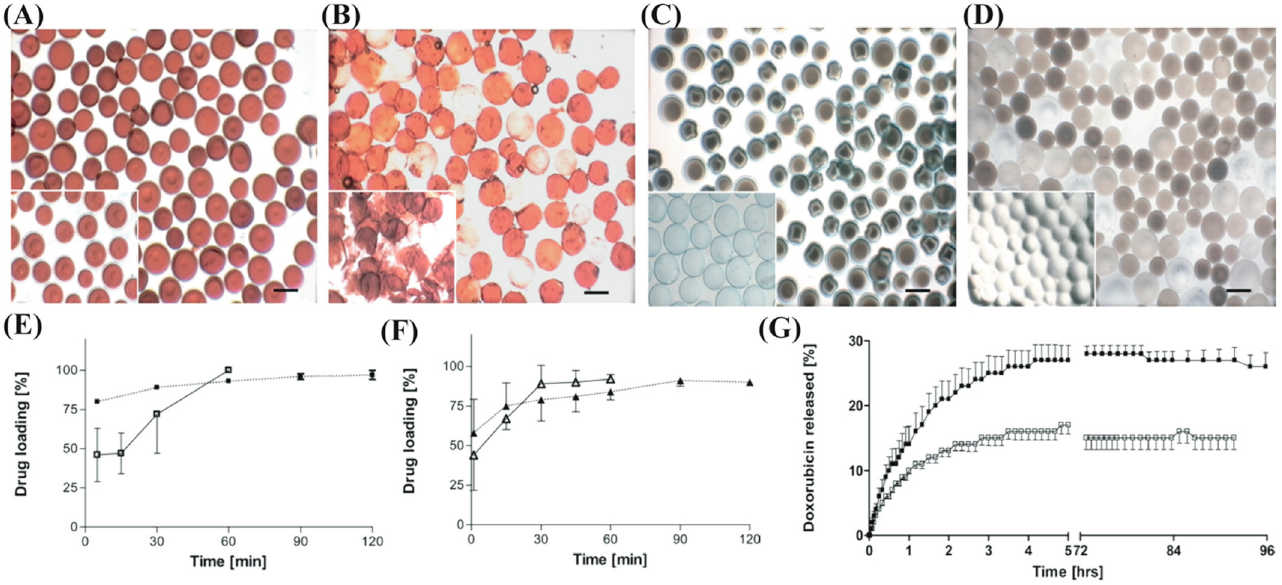
Figure 2. Loading and release profile of doxorubicin and irinotecan onto DC Bead ® and HepaSpher- e TM . Photomicrographs of doxorubicin-loaded ( A ) DC Bead ® and ( B ) HepaSphere TM . Irinotecan- loaded ( C ) DC Bead ® and ( D ) HepaSphere TM . ( E ) Loading kinetics of doxorubicin onto DC Beads ® (filled box) and HepaSpheres TM (empty box). ( F ) Irinotecan loading profile onto DC Beads ® (filled triangle) and HepaSpheres TM (empty triangle). ( G ) Release kinetics of doxorubicin from DC Beads ® (filled box) and HepaSpheres TM (empty box). Reproduced with permission from Ref